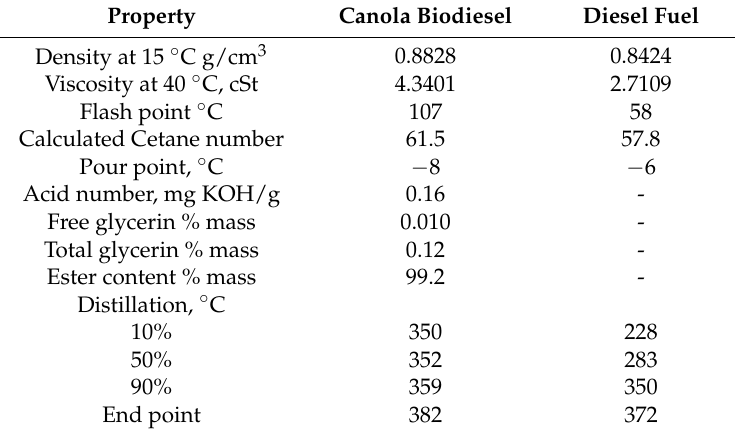
Table 1. The fuel properties of biodiesels and diesel fuels